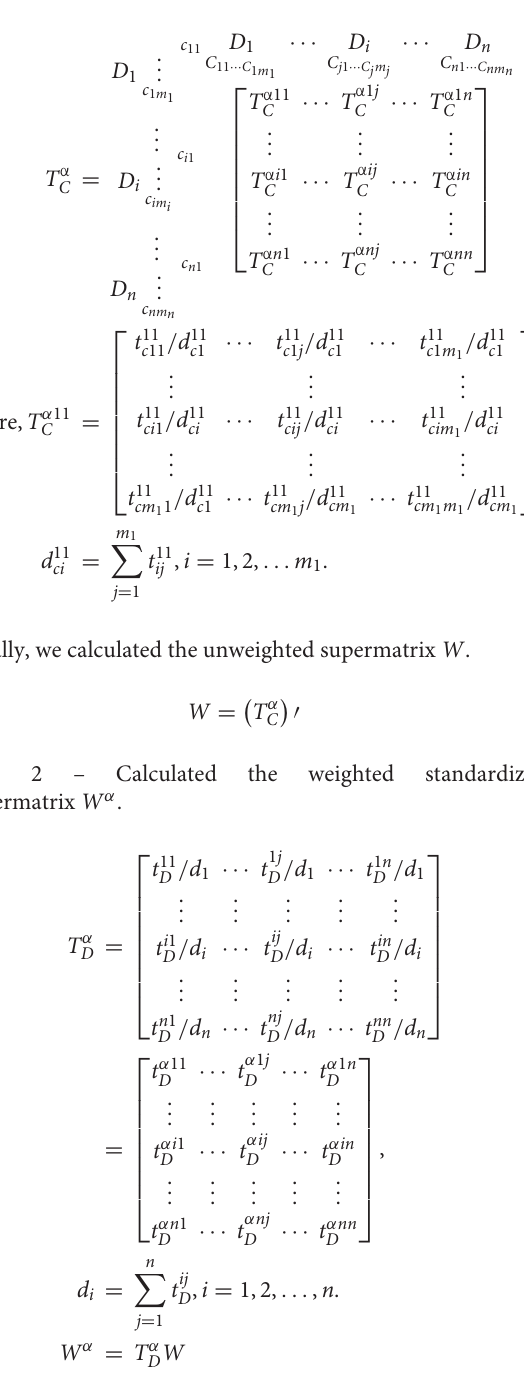
are required to score the pairwise relationship between the factors according to the corresponding integer values in Table 2